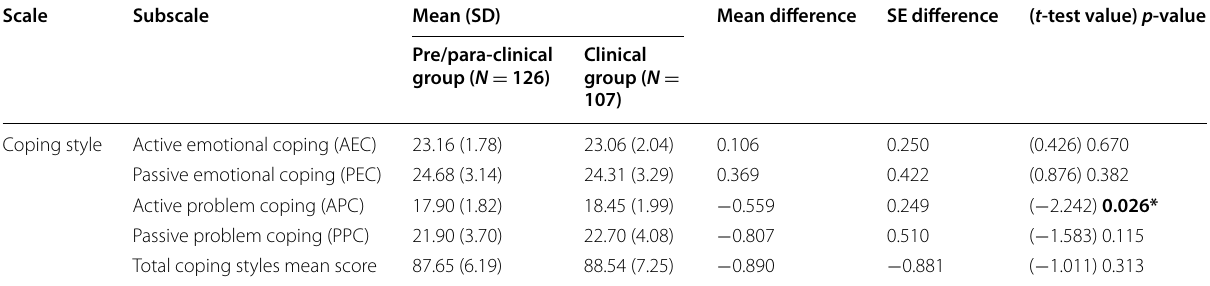
Table 7 Comparison of mean scores of coping styles between pre/para-clinical and clinical students with psychological morbidities